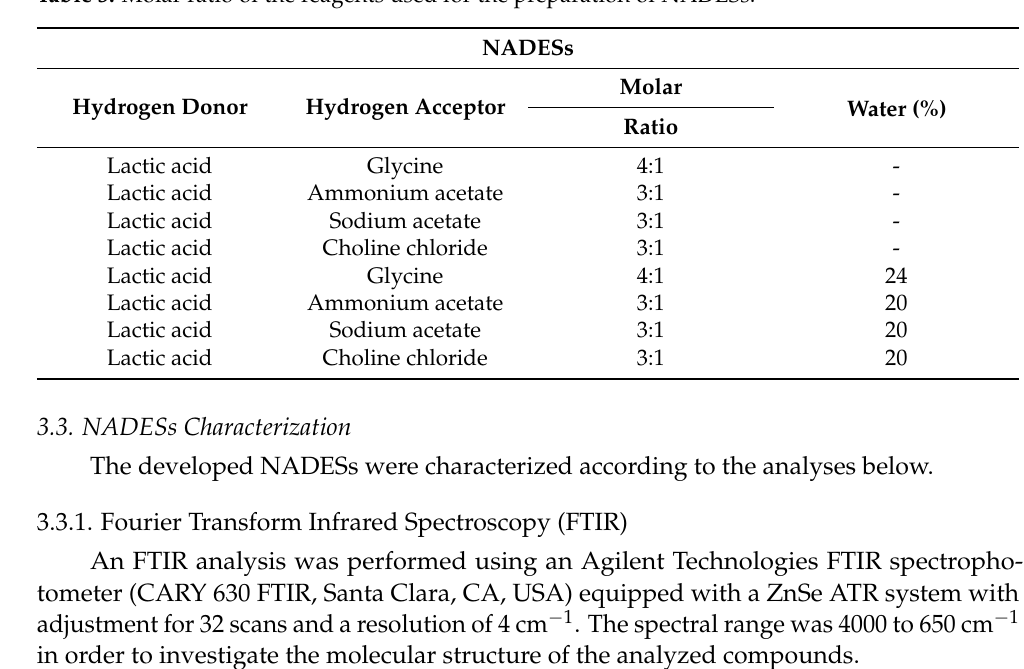
Table 3. Molar ratio of the reagents used for the preparation of